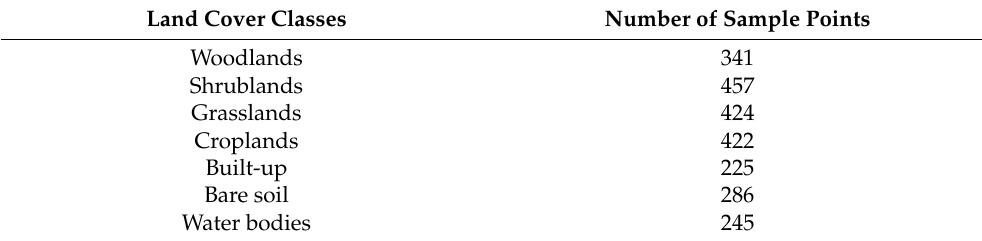
Table 1. Land cover classes and number of sample points used in the research.